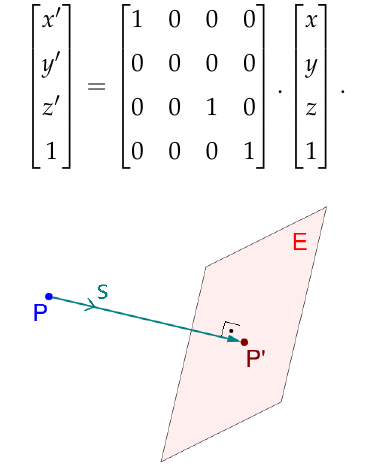
Figure 6. Orthogonal